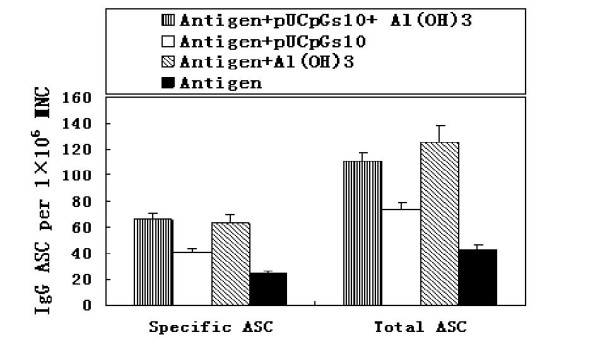
(a-b). Houmal immunity responses by CD19+CD27+ and CD19+CD38+ B cells against polyprotein with different adjuvants measured by flow cytometry. Mice were immunized three times with the HCVE1+HVR1 polyprotein and splenocytes were isolated. The surface of cells stained for CD19(APC), CD27(PE) or CD38 (FITC). The data are presented as the mean percentage ± SD of CD19 positive cells of total CD27+ or CD38+ cells of spleens of four groups from four mice. The proportion of CD19+ CD27+ spleen lymphocyte of the four groups are 2.06 ± 0.34, 1.15 ± 0.08, 1.72 ± 0.49, 1.29 ± 0.78(a); The proportion of CD19+ CD38+ spleen lymphocyte of the four groups are 46.42 ± 2.21, 40.17 ± 6.40, 38.91 ± 11.52, 29.47 ± 8.49(b);